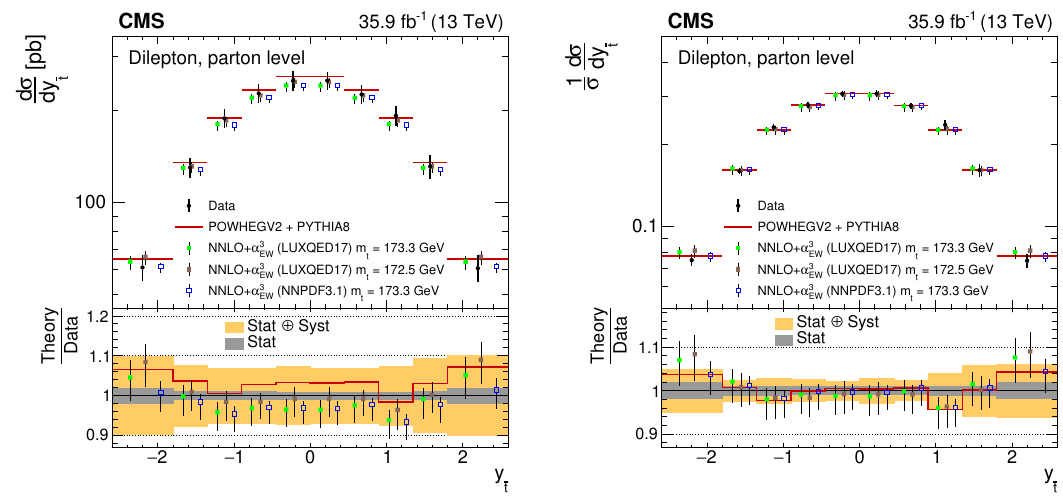
Figure 16 . The di(cid:11)erential tt production cross sections at the parton level in the full phase space as a function of y are shown for the data ((cid:12)lled circles), the theoretical predictions with beyond- t NLO precision (other points) and the prediction from powheg + pythia (solid line). The vertical lines on the (cid:12)lled circles and other points indicate the total uncertainty in the data and theoretical predictions, respectively. The left and right plots correspond to absolute and normalised measure- ments, respectively. The lower panel in each plot shows the ratios of the theoretical predictions to the data. The dark and light bands show the relative statistical and total uncertainties in the data, respectively.